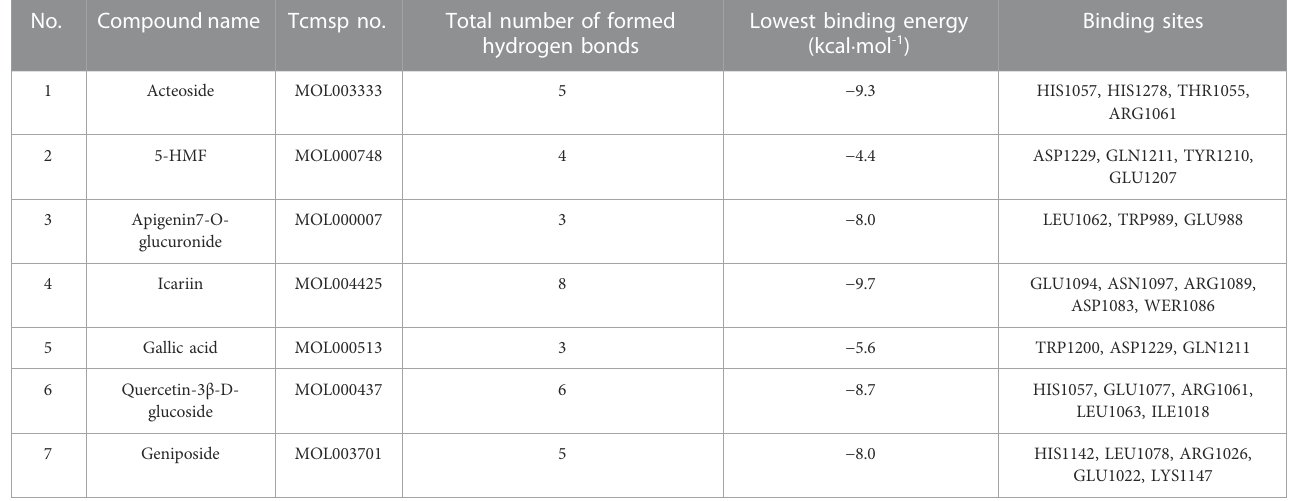
TABLE 1 Summary of compounds binding to INSR protein in the